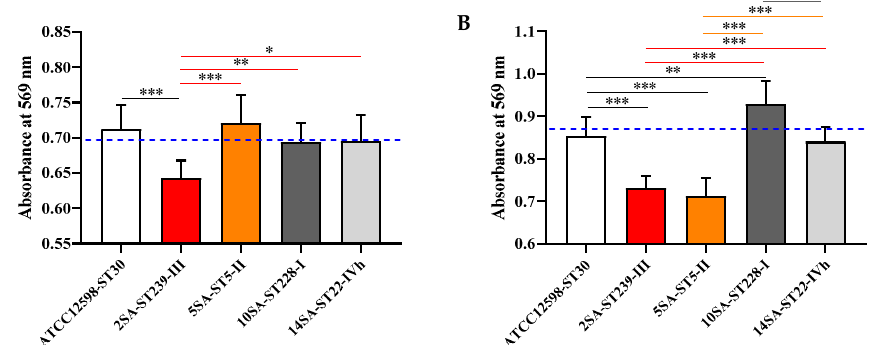
Figure 2. Changes in cell viability of MG-63 osteoblast-like cells infected at a multiplicity of infection (MOI) of 100:1 with five different S. aureus strains detected after ( A ) 3 h and ( B ) 24 h. Values are reported as absorbance measured at 569 nm and represent the means ± SD of at least five independent experiments. Blue-dotted line indicates the absorbance measured at 569 nm for uninfected MG-63 cells. Significant comparisons between each experimental condition are indicated by lines. * Significantly different, p < 0.05; ** significantly different, p < 0.01; *** significantly different, p <